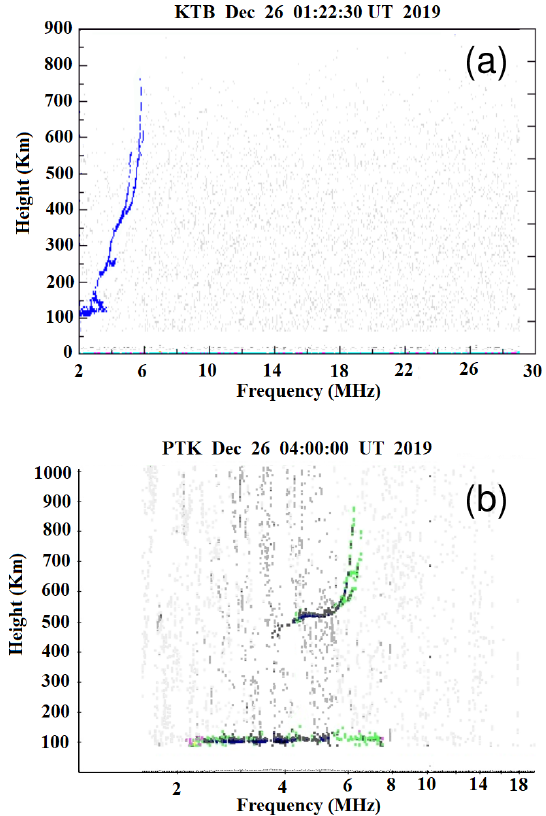
Figure 2. Sample ionograms from (a) Kototabang station at 01:22UTC on 26 December 2019 and (b) Pontianak station at 12:00LT (05:00UTC) on 26 December 2019. Main return traces in these sample ionograms have been enhanced to make them stand out against high levels of background noise. Ionograms from these two stations were subject to a manual scaling process in order to extract essential ionospheric